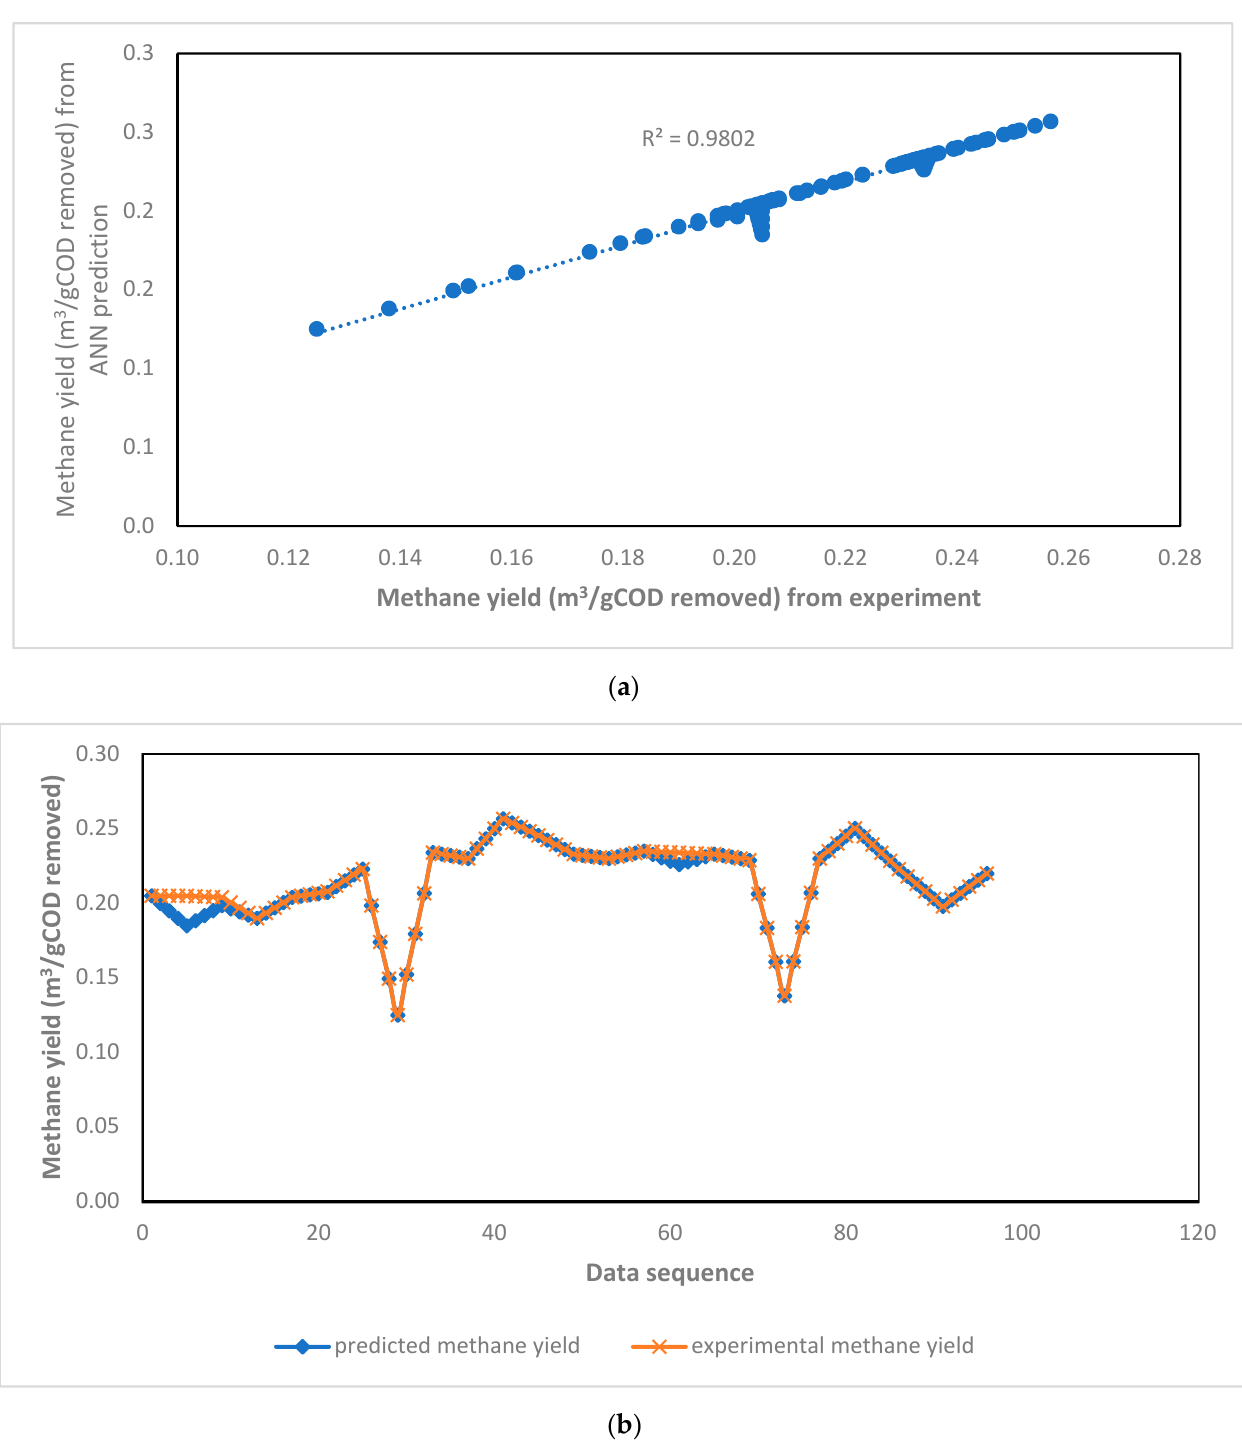
15 of 38 ( b ) Figure 4. ( a ) Correlation between experimental data and predicted value of percentage of CH4 in biogas. ( b ) Prediction value and measured data by ANN model for percentage of CH4 in biogas. The R value for predicting the value of methane purity for each hidden neuron can be found in Table A15 (Appendix). The BR algorithm produced the best performance